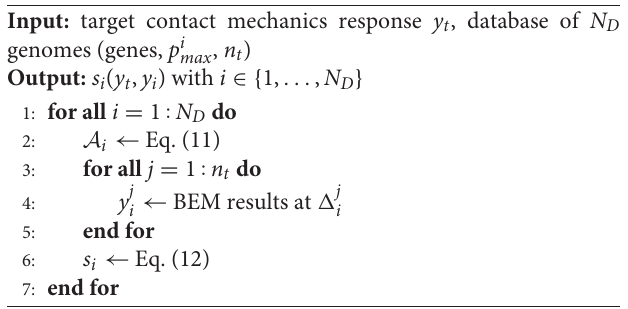
Algorithm 2 | Similarity score extraction from a database of genomes